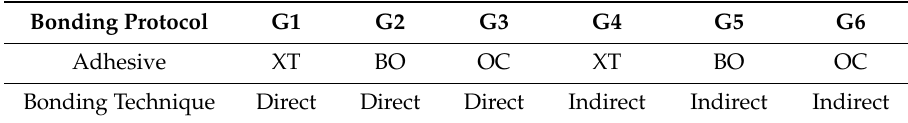
Table 2. Study design of the groups to compare the shear bond strength (SBS) and the adhesive remaining index (ARI) using three adhesive systems and two bonding techniques (direct and indirect bonding).